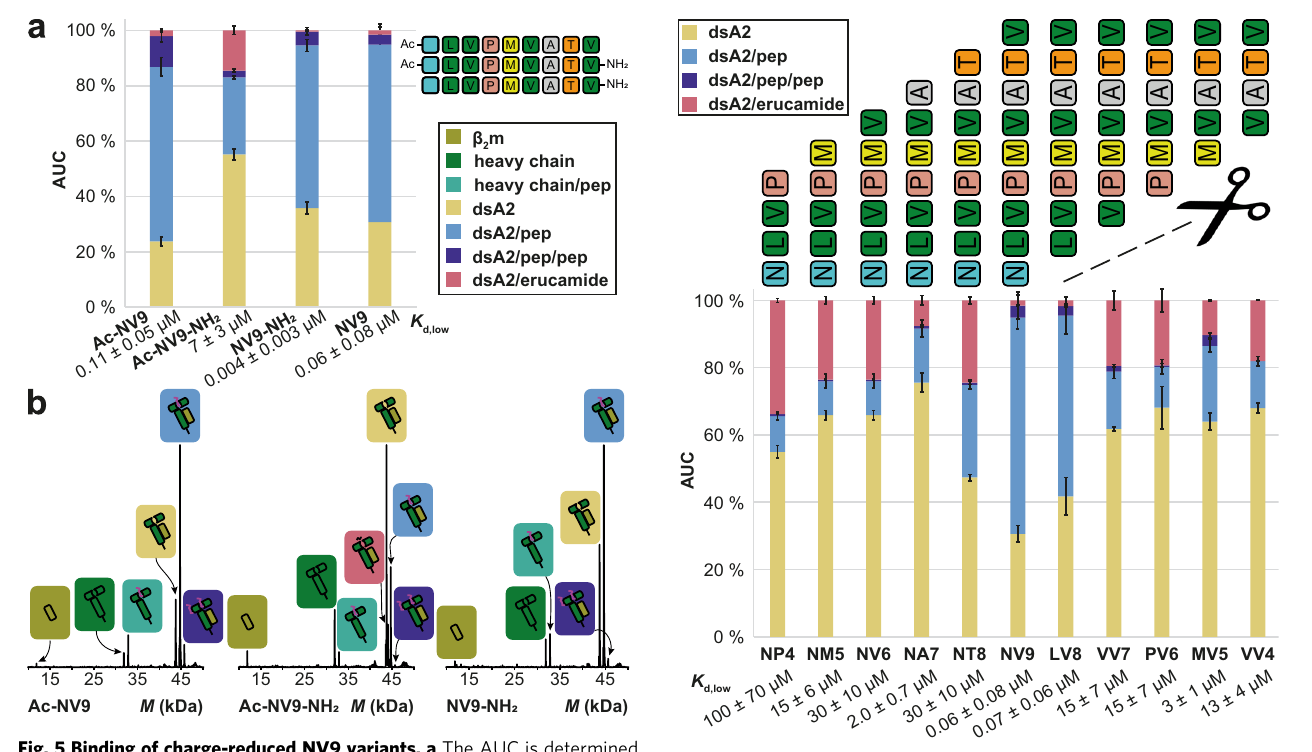
Fig. 6 Truncated NV9 variants analyzed at 10 V. The AUC is determined over the entire spectrum for the respective mass species, which is depicted along with error bars that represent the corresponding standard deviation. “ dsA2 ” (yellow bars) corresponds to the empty complex, “ dsA2/pep ” (light blue bars) to dsA2 bound to one peptide, “ dsA2/pep/pep ” to dsA2 bound to two molecules of this certain peptide (dark blue bars) and “ dsA2/ erucamide ” to dsA2 bound to the erucamide (coral) respectively. Octa- and nonapeptides have the highest binding ef fi ciency in accordance with their biological function. Without the anchor residues Leu-2 and Val-9 in a truncated NV9 variant, the af fi nity decreases drastically. A terminal methionine appears to enhance the af fi nity of the peptide to dsA2. The corresponding K d,low is shown for respective truncated pentapeptide MV5 performs signi fi cantly better than the corresponding hexa- (PV6) and heptapeptides (VV7). The increased proportion of dsA2/MV5 at 50 V (Fig. S5) and the simultaneous occurrence of dsA2/MV5/MV5 (dark blue bars, Fig. 6) strongly suggest that MV5 occupies an additional binding site within the peptide groove. Since this effect is not apparent for the smaller VV4, the terminal methionine seems to be decisive.